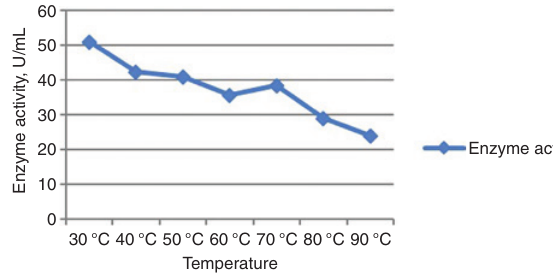
Figure 4: Effect of temperature on enzyme activity.